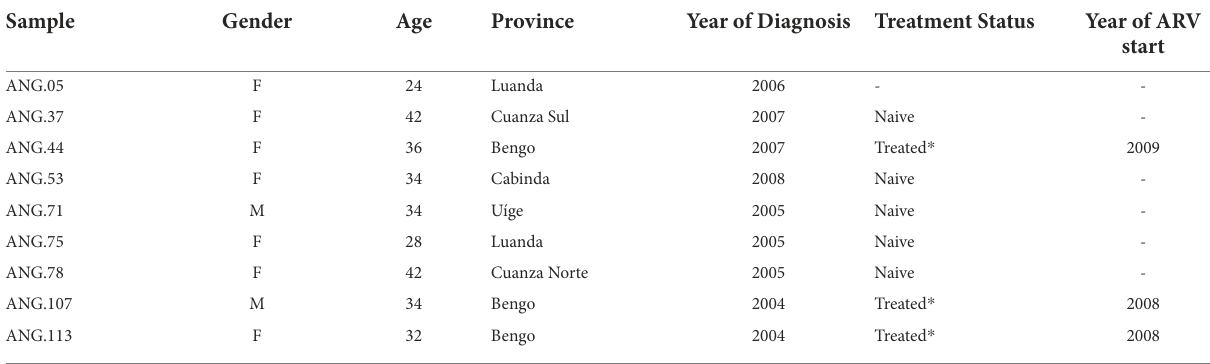
TABLE 1 Sociodemographic and clinical data of the studied